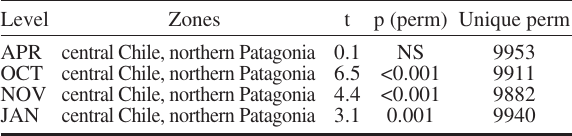
Patagonia.Table 4. – PERMANOVA pairwise tests of differences in multi- Table 3. – Post-hoc univariate pairwise Wilcoxon test comparisons elemental concentrations in otolith cores between zones and of element/calcium ratios in anchoveta otolith cores and edges be- tween central Chile and northern Patagonia. Statistically significant values are indicated in bold.